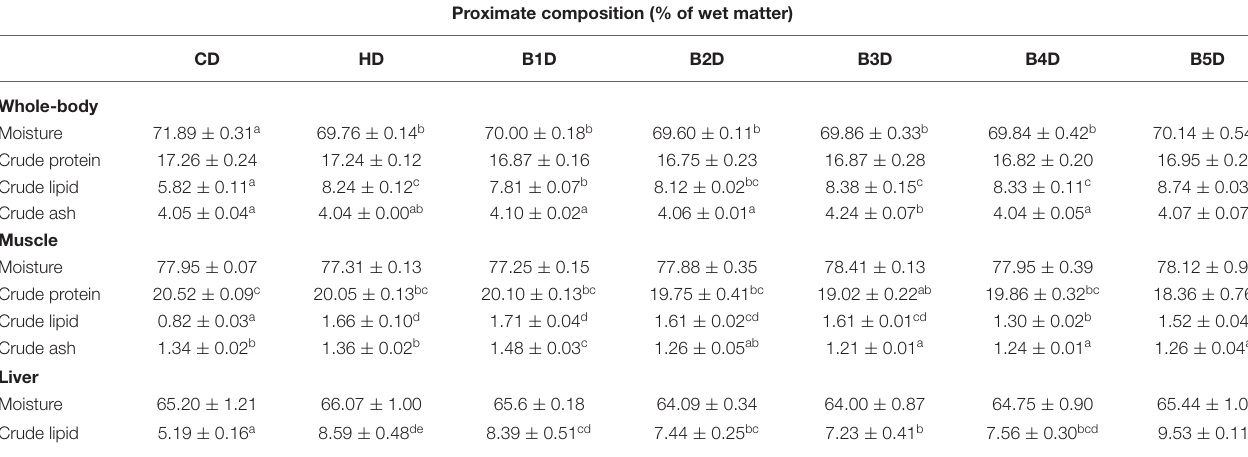
TABLE 2 | Average proximate composition of the whole-body, muscle, and liver in diet groups. Proximate composition (% of wet